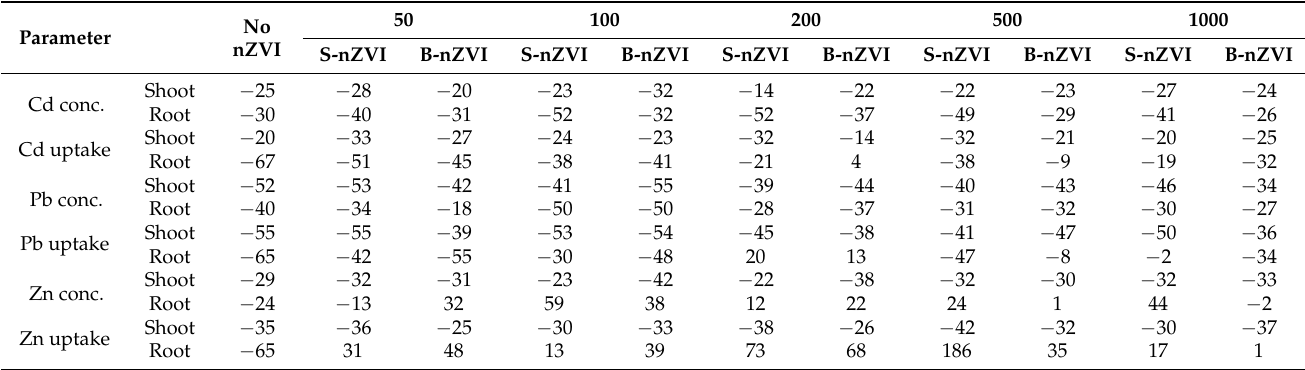
Table 4. Mycorrhizal response (%) as influenced by